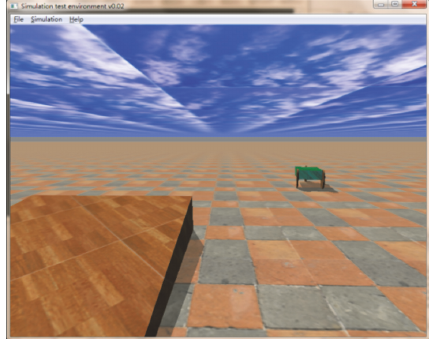
Figure 3: Forward, backward, acceleration, and deceleration of the vehicle